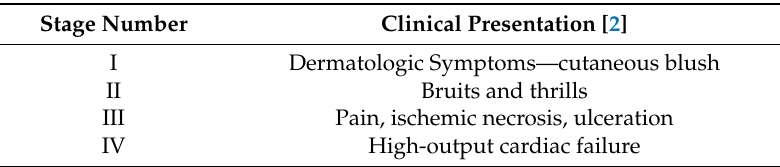
Table 3. Schobinger staging system